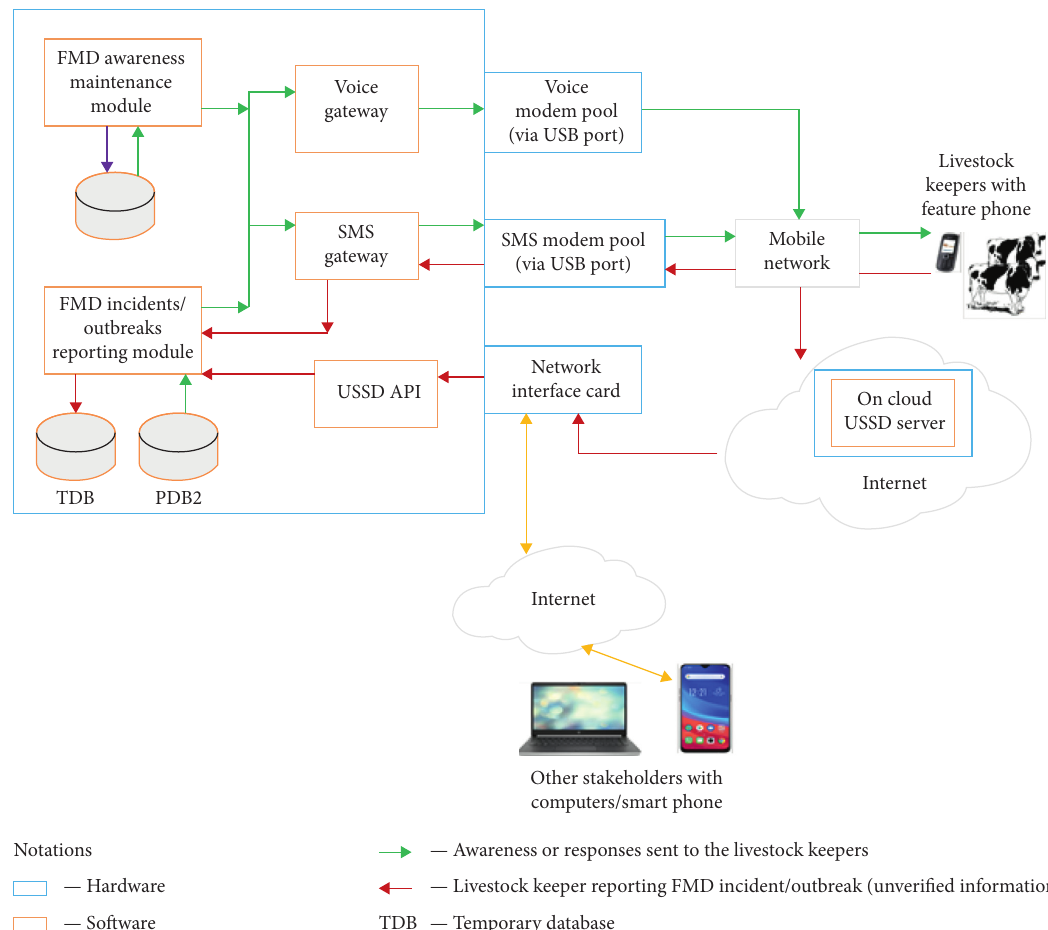
Figure 4: Block diagram of system